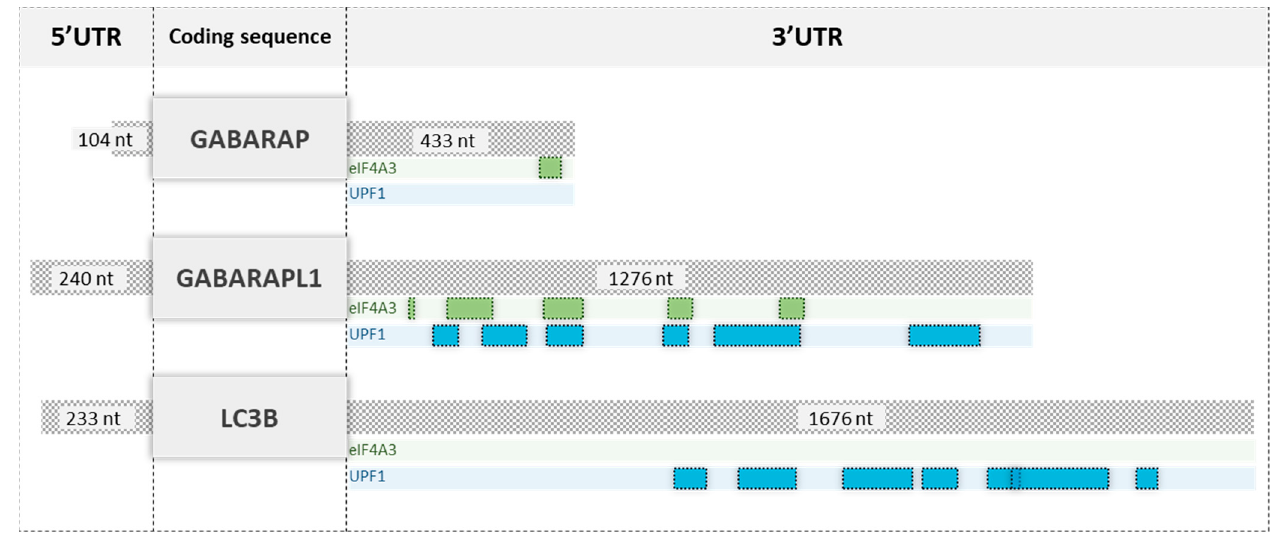
Figure 7. Schematic representation of eIF4A3 and UPF1 binding sites on the 3 ′ UTR of GABARAP , GABARAPL1 and LC3B . The experimental binding sites of eIF4A3 and UPF1 were studied using the AURA 2.5.2 database.